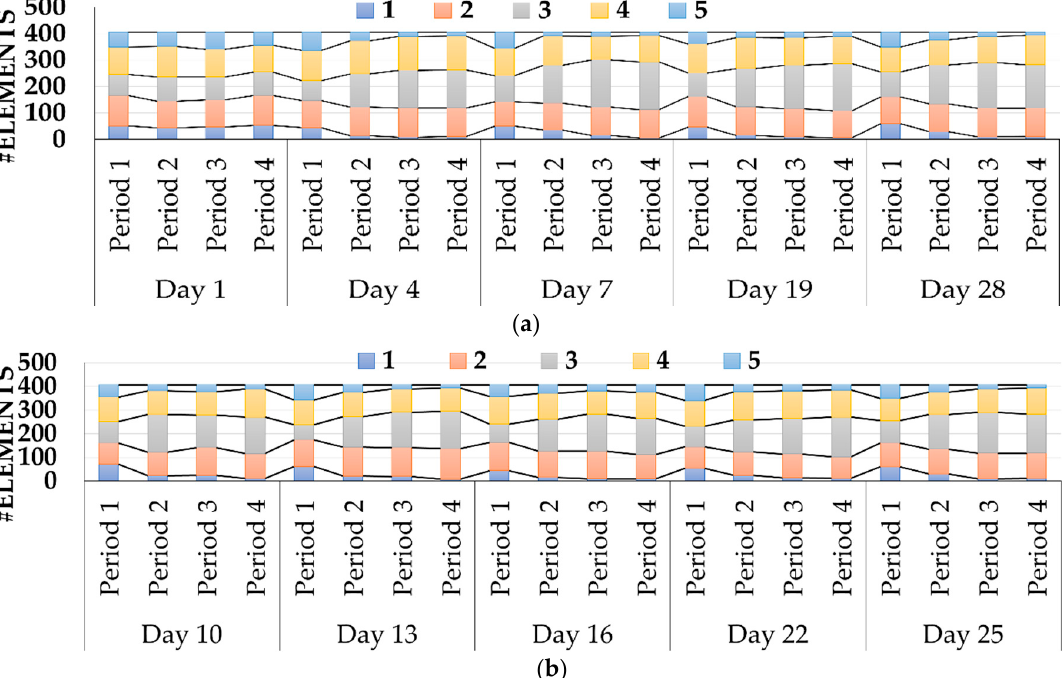
Figure 9. Number of elements per Reliability Rate regarding final rate: ( a ) DR event 1; ( b ) DR event